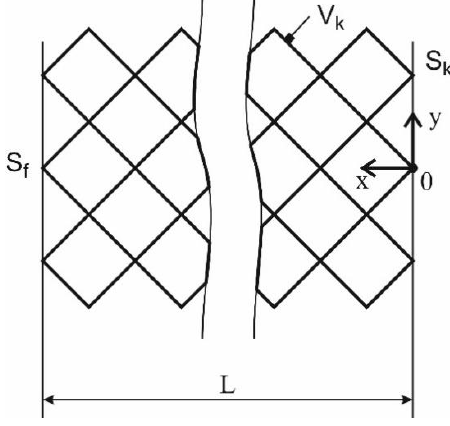
Figure 2. The design of lattice endoprosthesis.